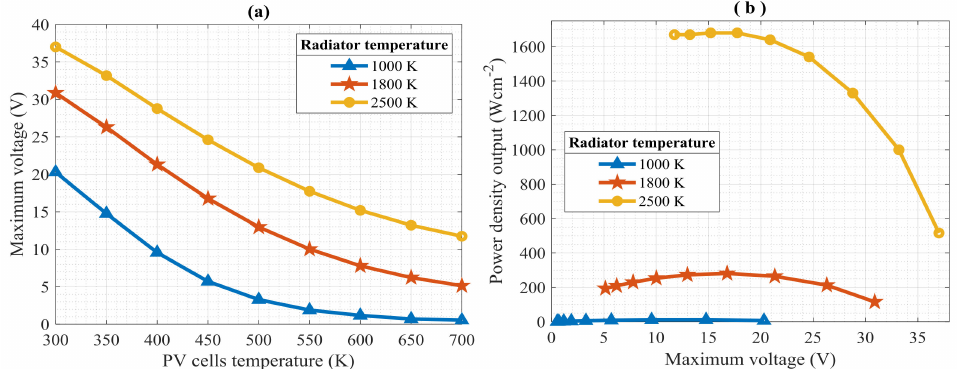
Figure 9. Relationship between ( a ) PV cells temperature and maximum voltage, ( b ) maximum voltage, and power density outputs for radiator temperature at 1000, 1800, and 2500